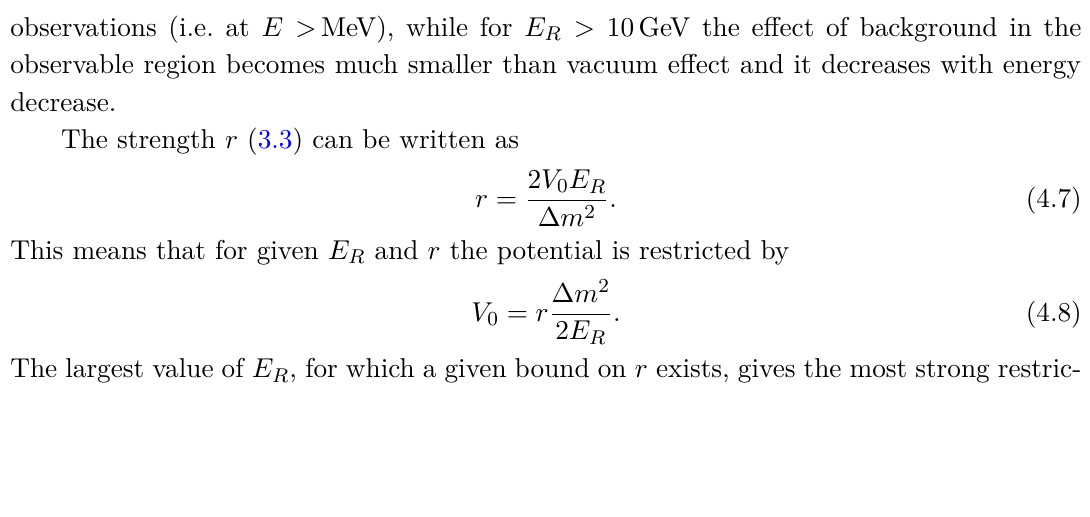
Figure 6 . The effective mass squared difference as function of the neutrino energy for different values or r . The curves are normalized at E → 0 to the value of the ∆ m 2 the data. Explanation of the MiniBooNE requires r > 1 . 6 . Shown are the values of ∆ m 2 and ∆ m 2 extracted from experiments at different ee